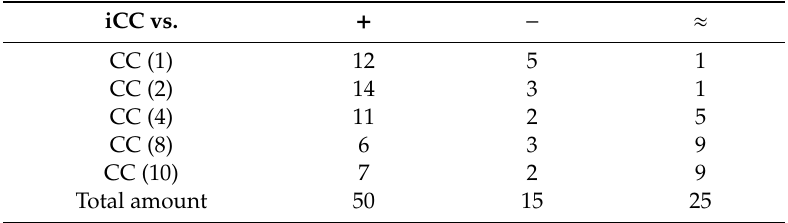
Table 5. Mann–Whitney U test, pop_size is 75.